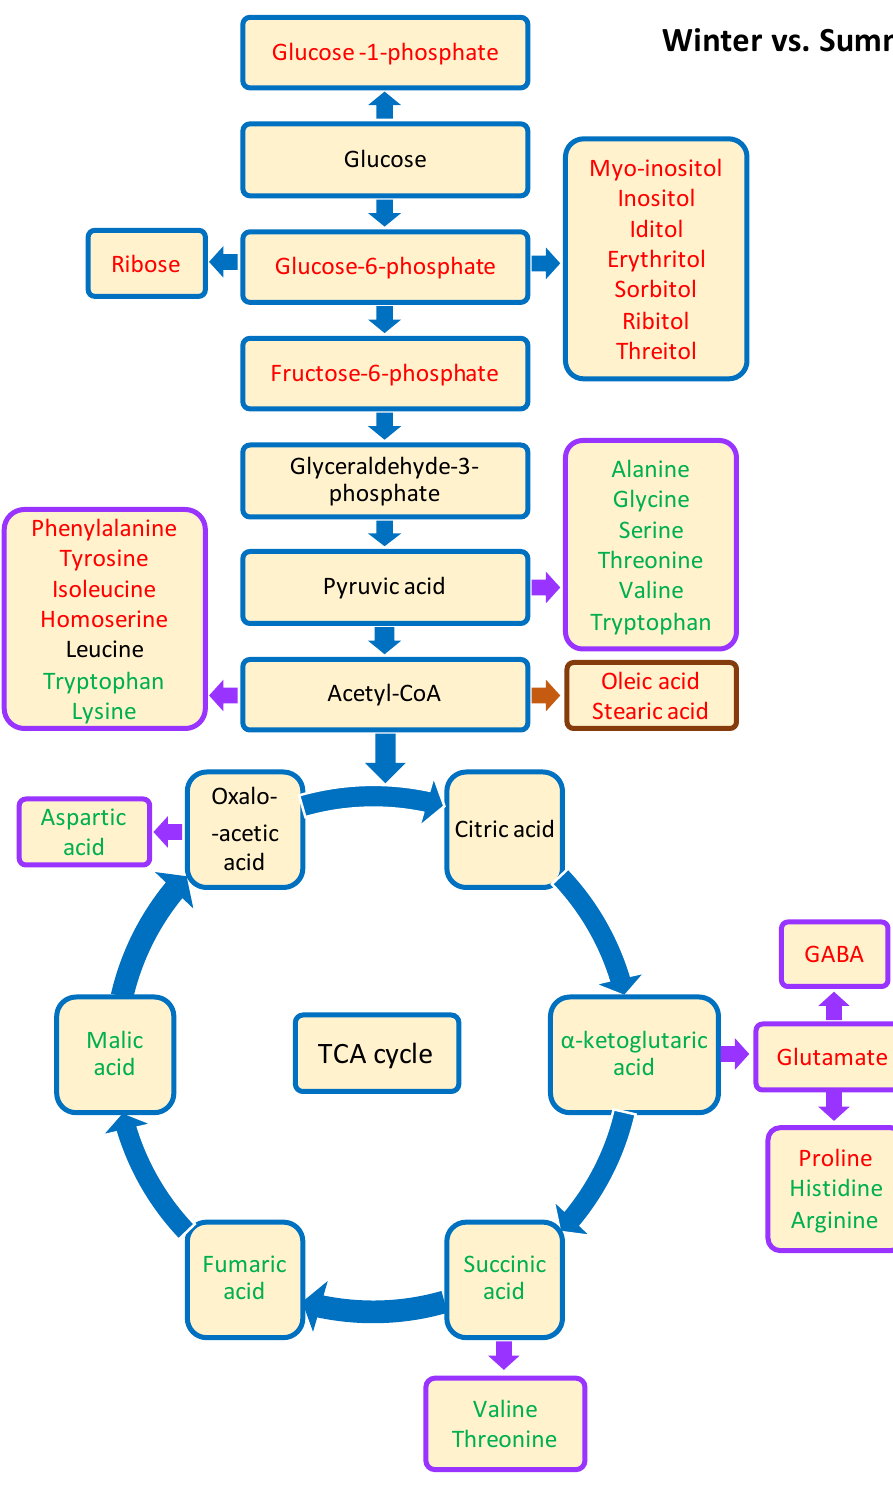
Figure 4. A simplified model of metabolite changes in aphids between the two distinct seasons. Blue arrows and boxes, carbohydrate metabolism; purple arrows and boxes, amino acid metabolism; brown arrow and box, fatty acid metabolism. Red colour indicates upregulated metabolites, green indicates downregulated metabolites, and black indicates no significant change in metabolite levels.